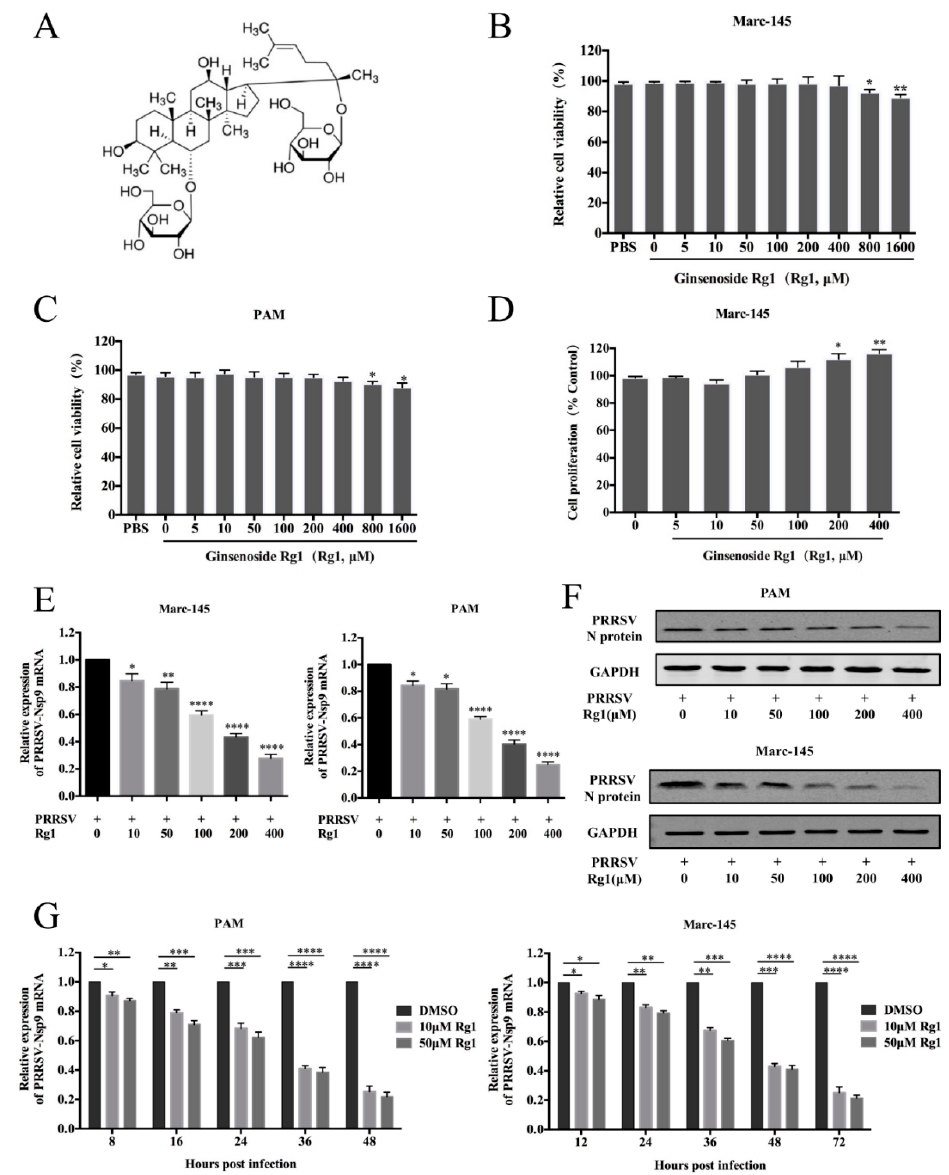
Figure 1. Cytotoxicity and anti-PRRSV activity of Rg1 in Marc-145 cells and PAMs. ( A ) The chemical structures of ginsenoside Rg1 (Rg1). ( B , C ) Cytotoxicity of Rg1 in Marc-145 cells ( B ) and PAMs ( C ) were analyzed by using the WST-1 assay. Results are showed as the relative cell viability of PAMs or Marc-145 cells cultured without Rg1 (set as 100%). ( D ) Rg1 a ff ects the proliferation of Marc-145 cells. Cells were seeded and cultured without FBS for 12 h and the medium was replaced with DMEM contains 0, 5, 10, 50, 100, 200 and 400 µ M Rg1 respectively. ( E , F ) PRRSV XH-GD (0.1 MOI) infected Marc-145 cells or PAMs for 1 h at 37 ◦ C, and then cells were cultured in DMEM or RPMI 1640 supplemented with 2% FBS and indicated concentrations of Rg1. The samples were collected at 48 hpi to analyze PRRSV Nsp9 mRNA levels in di ff erent groups by RT-PCR ( E ). N protein expression levels in cells treated with di ff erent concentrations of Rg1 were detected by western blot ( F ). ( G ) Marc-145 cells and PAMs infected with PRRSV XH-GD (0.1 MOI) for 1 h at 37 ◦ C and then cultured in fresh medium supplemented with 10 or 50 µ M Rg1. The expression levels of PRRSV Nsp9 in Marc-145 cells and PAMs were detected by RT-PCR analysis at the indicated time points. Each data represents results of three independent experiments (means ± SD). Significant di ff erences compared with the control group are denoted by * ( p < 0.05), ** ( p < 0.01), *** ( p < 0.001) and **** ( p <